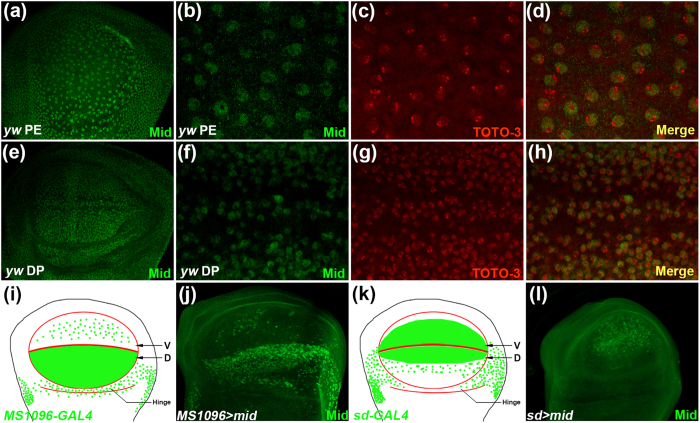
Mid is expressed in the PE and DP of wing discs.(a–h) The expression pattern of Mid in the wing disc from a third instar larva of wild type stained with anti-Mid antibody. Optical sections at the plane of the PE (a–d) and DP (e–h). Mid was detected in the nucleus, labeled by TOTO-3, of both PE (b–d) and DP (f–h) cells. (i) Schematic representation of the MS1096-GAL4 expression pattern. (j) The expression of Mid in the MS1096-Gal4;UAS-mid wing disc. (k) Schematic representation of the sd-GAL4 expression pattern. (l) The expression of Mid in the sd-Gal4;UAS-mid wing disc.